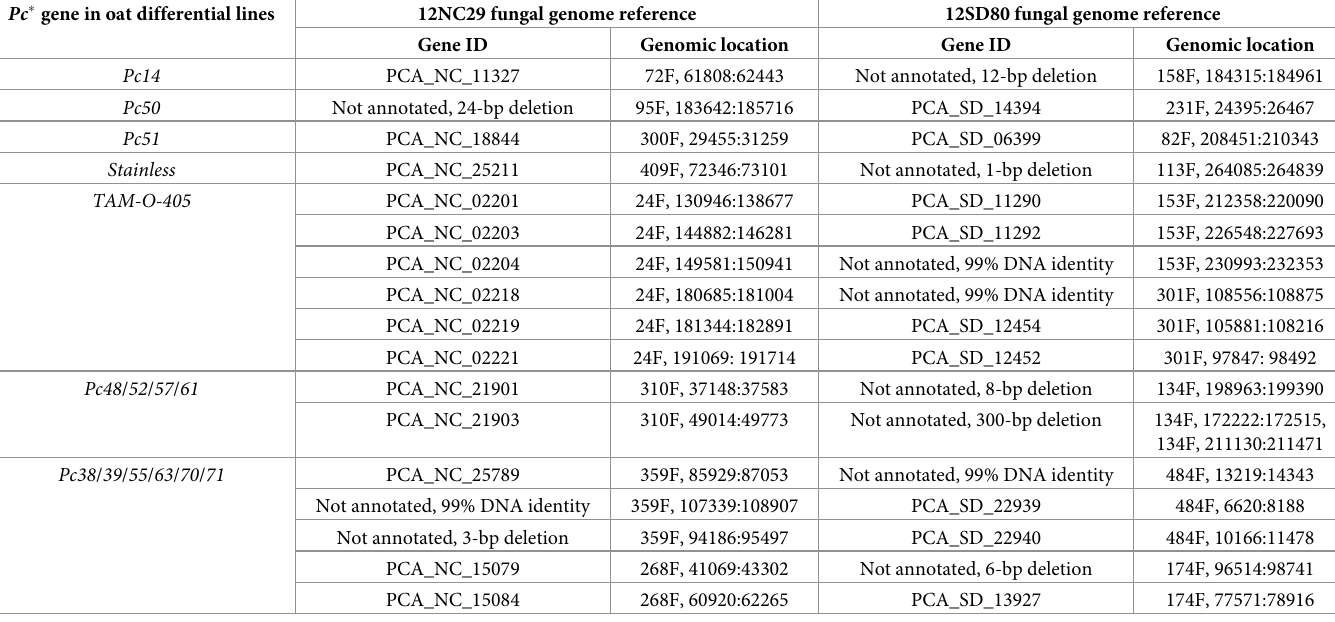
Table 2. Summary of candidate Avr genes detected by genome-wide association of virulence to specific R genes. Pc � gene in oat differential